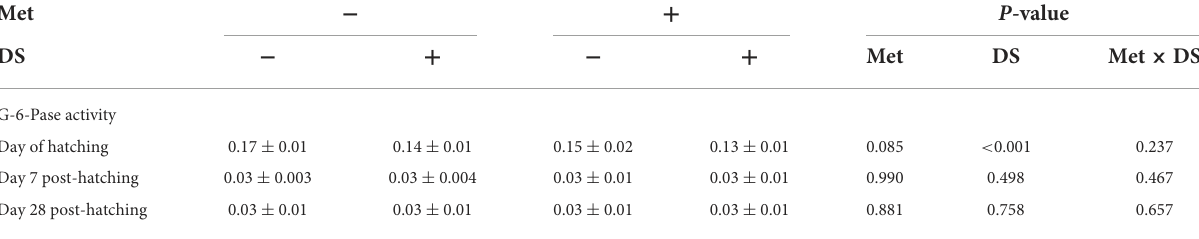
TABLE 6 Effects of in ovo injection of methionine (Met) and disaccharide (DS) on glucose 6-phosphatase (G-6-Pase) activity of geese during the early-life post-hatching a,b . Met −